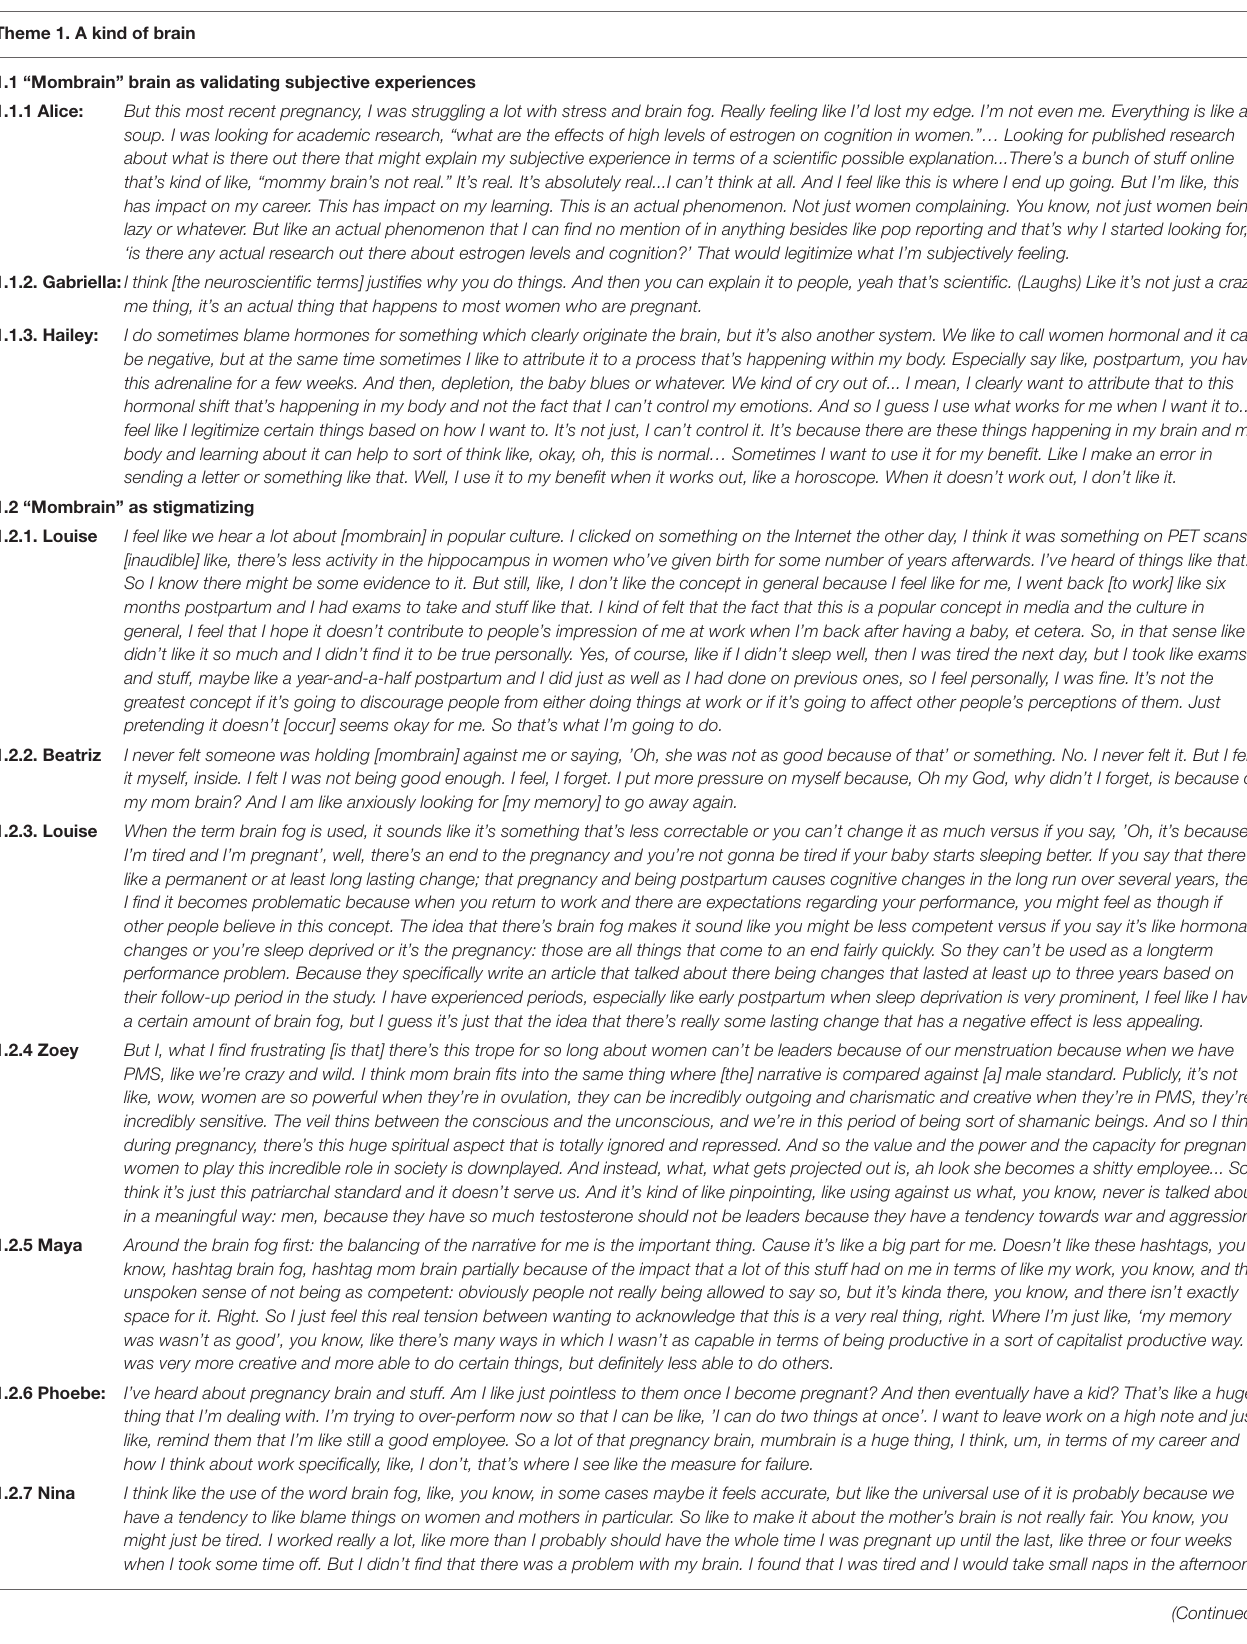
TABLE 2 | Focus group discussion narrative